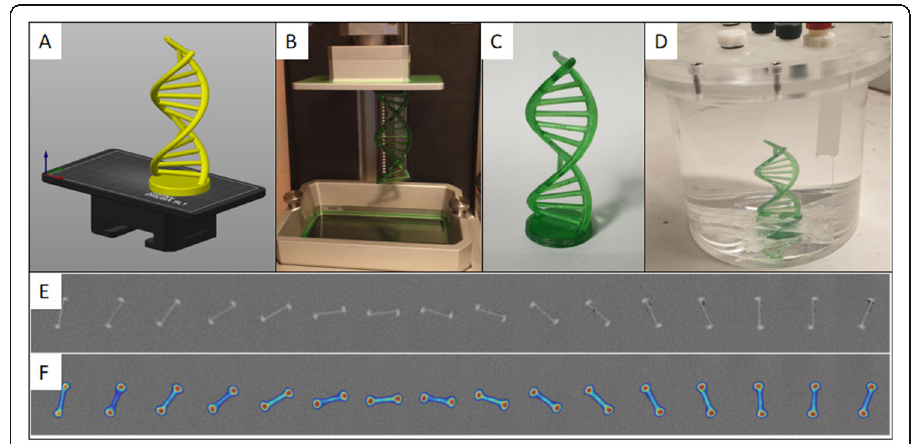
Fig. 6 Helix model prepared for printing in PrusaSlicer ( a ). Helix after printing ( b ). Helix after removal from build plate, washed, dried and cured ( c ). Helix mounted in a cylinder of water for imaging ( d ). Axial CT slices ( e ). Axial PET/CT slices ( f